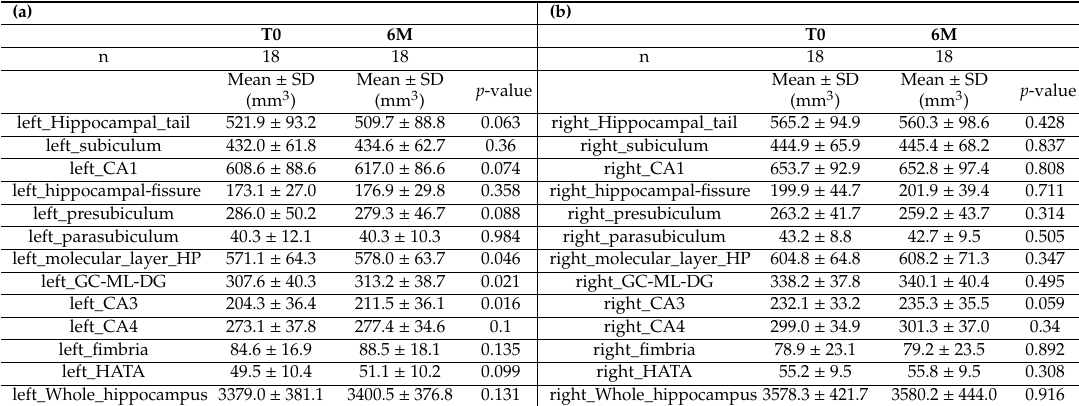
Figure 3. Subfield volume in hippocampus at left ( a ) and right ( b ). T0; baseline, 6M; after 6 months, Y-axis shows volume in hippocampus subfields (mm 3 ).Vertical bar means standard error (SEM). Table 1. Volumes of Hippocampal Subfields at left ( a ), and right ( b ).